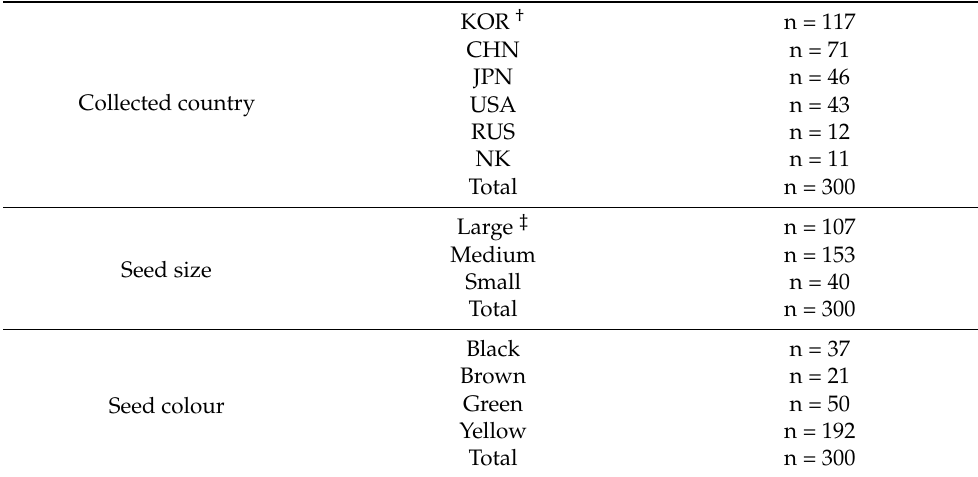
Table 1. Number of 300-soybean germplasms classified by collected country, seed size and colour.